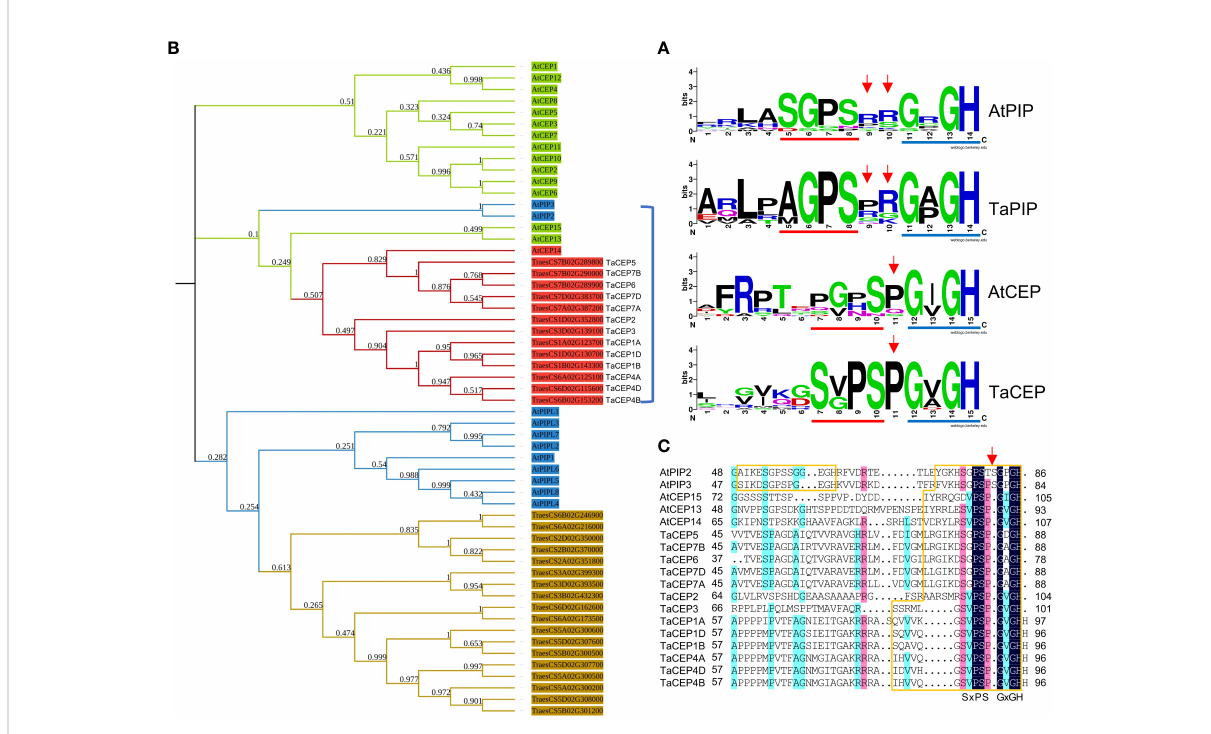
FIGURE 2 Identi fi cation of CEP family in wheat. (A) Logos of PIP and CEP peptides from Arabidopsis and wheat. Red and blue lines indicate SGPS and GxGH motif, red arrows indicate the amino acid insertions between these two domains. Logos were created by WebLogo online tool (https:// weblogo.berkeley.edu/logo.cgi). (B) Phylogenetic tree of AtPIPs, AtCEPs, TaPIPs and TaCEPs, generated from the alignment of the full length protein sequences using ClustalW. The phylogenetic tree was constructed by the maximum likelihood method with 1000 bootstrap replications. Different colors indicate different peptide families in Arabidopsis and wheat. (C) Multiple sequence alignment of peptides within blue bracket from (B) . The SSP domains were boxed in orange, red arrow indicates the additional amino acid insertion in AtPIP